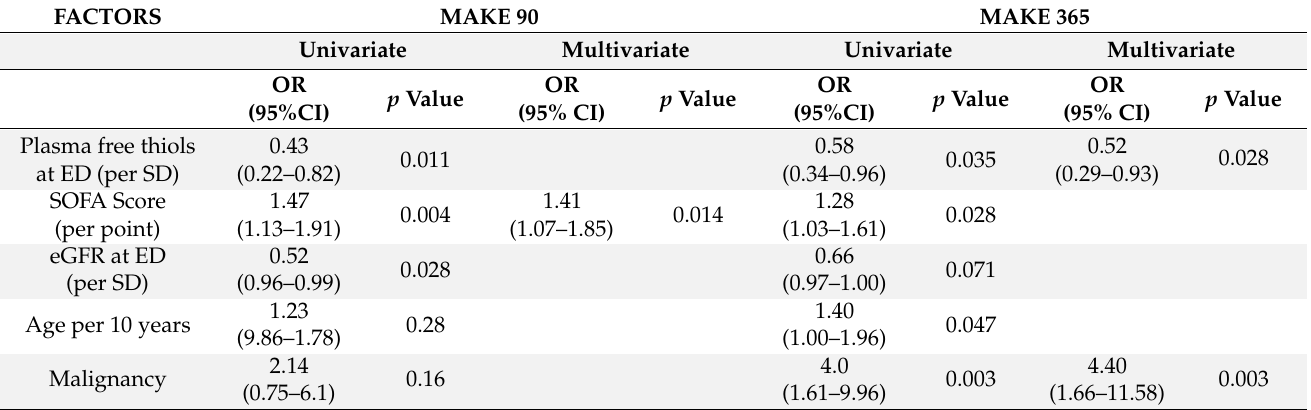
Table 2. Uni- and multivariate logistic regression analysis with composite endpoints MAKE90 and